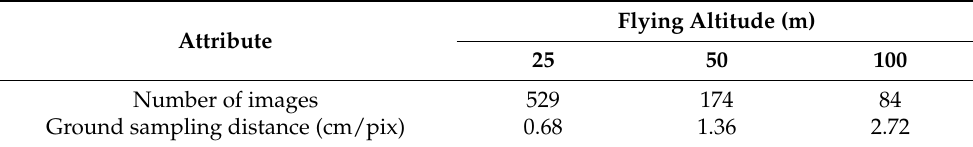
Table 1. Summary of unmanned aerial vehicle (UAV) data acquisition.